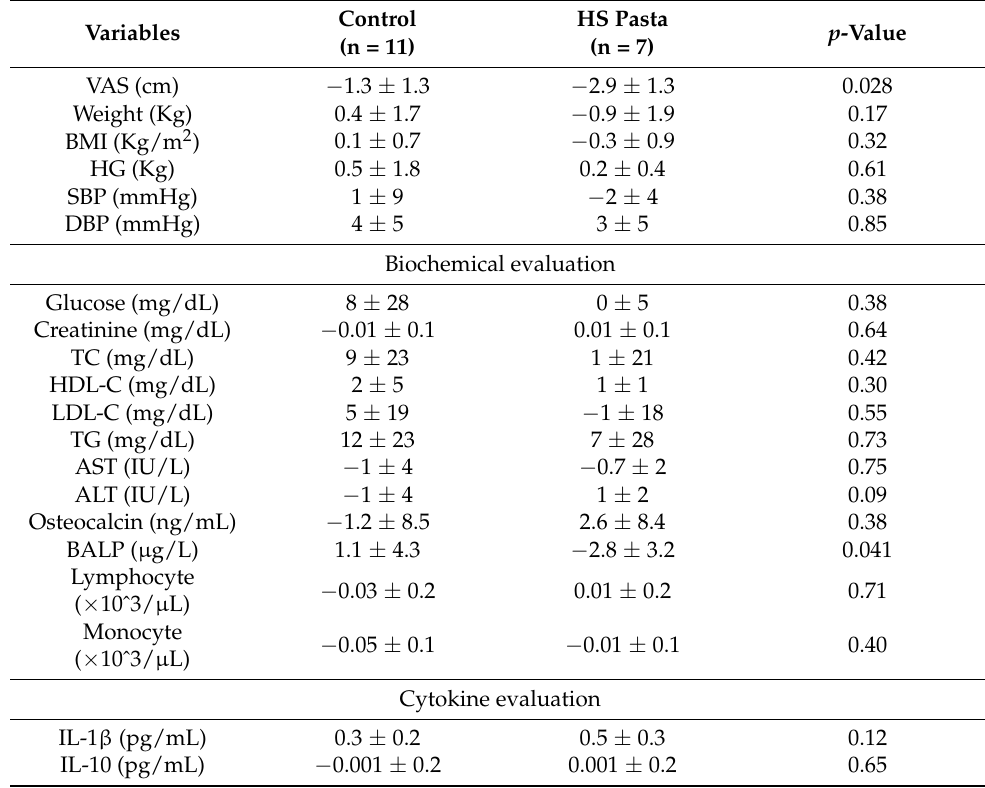
Table 2. Changes of the characteristics of participants at follow-up according to